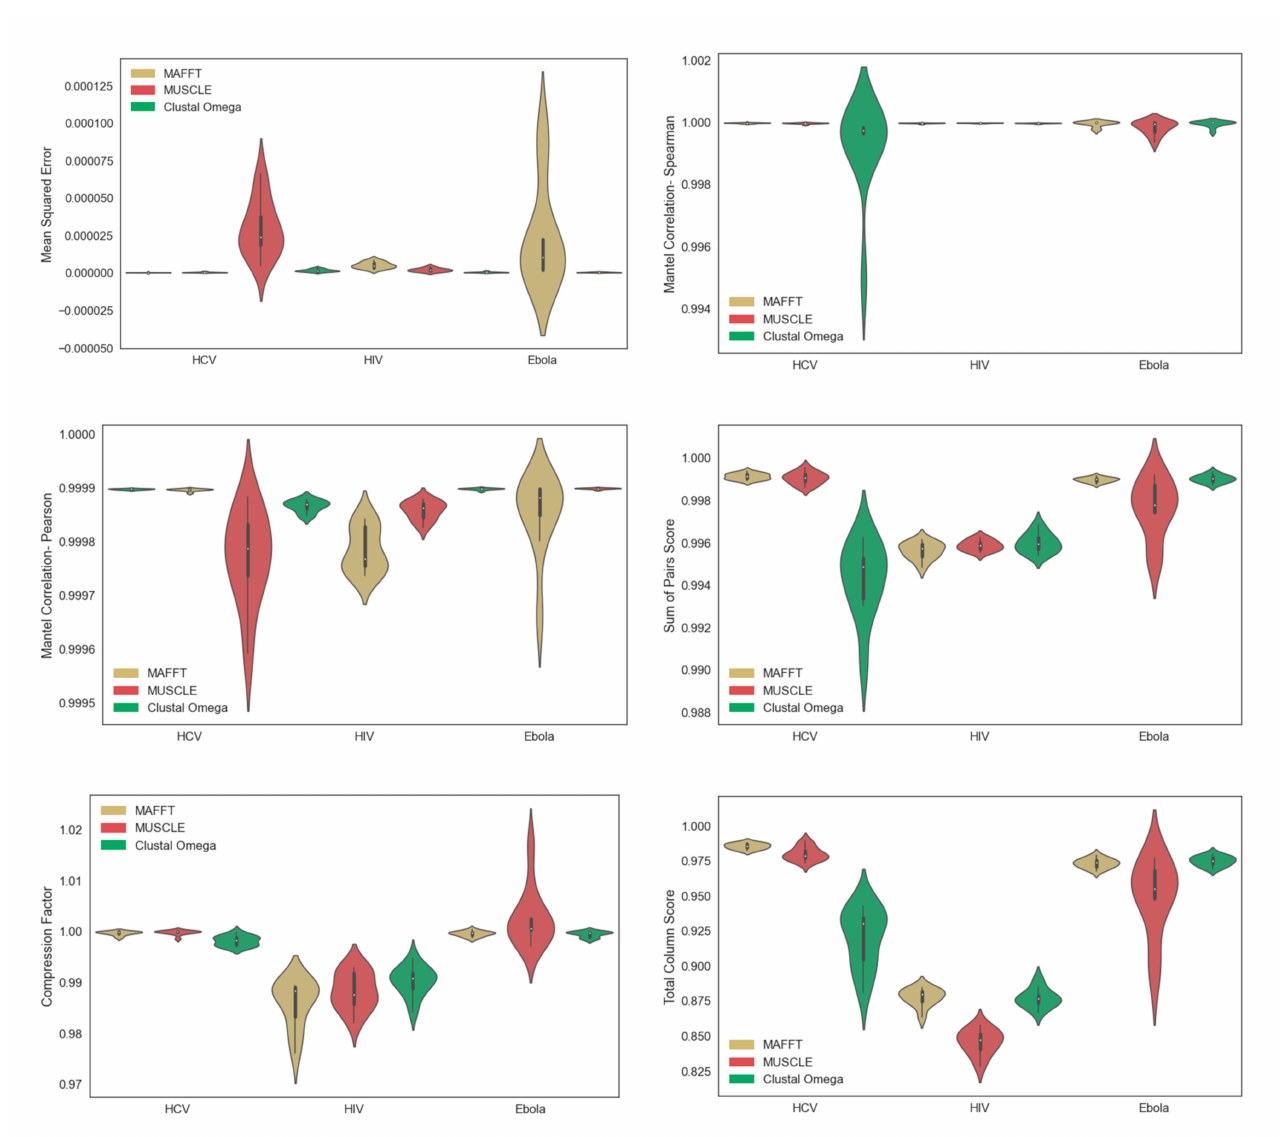
Figure 2. Metrics of sequence alignment accuracy for MAFFT, MUSCLE, and Clustal Omega on 10 simulated replicate datasets of HIV, HCV, and Ebola. Violin plots are shown for Mean Squared Error, Spearman/Pearson Mantel Correlation, SP score, TC score, and Compression